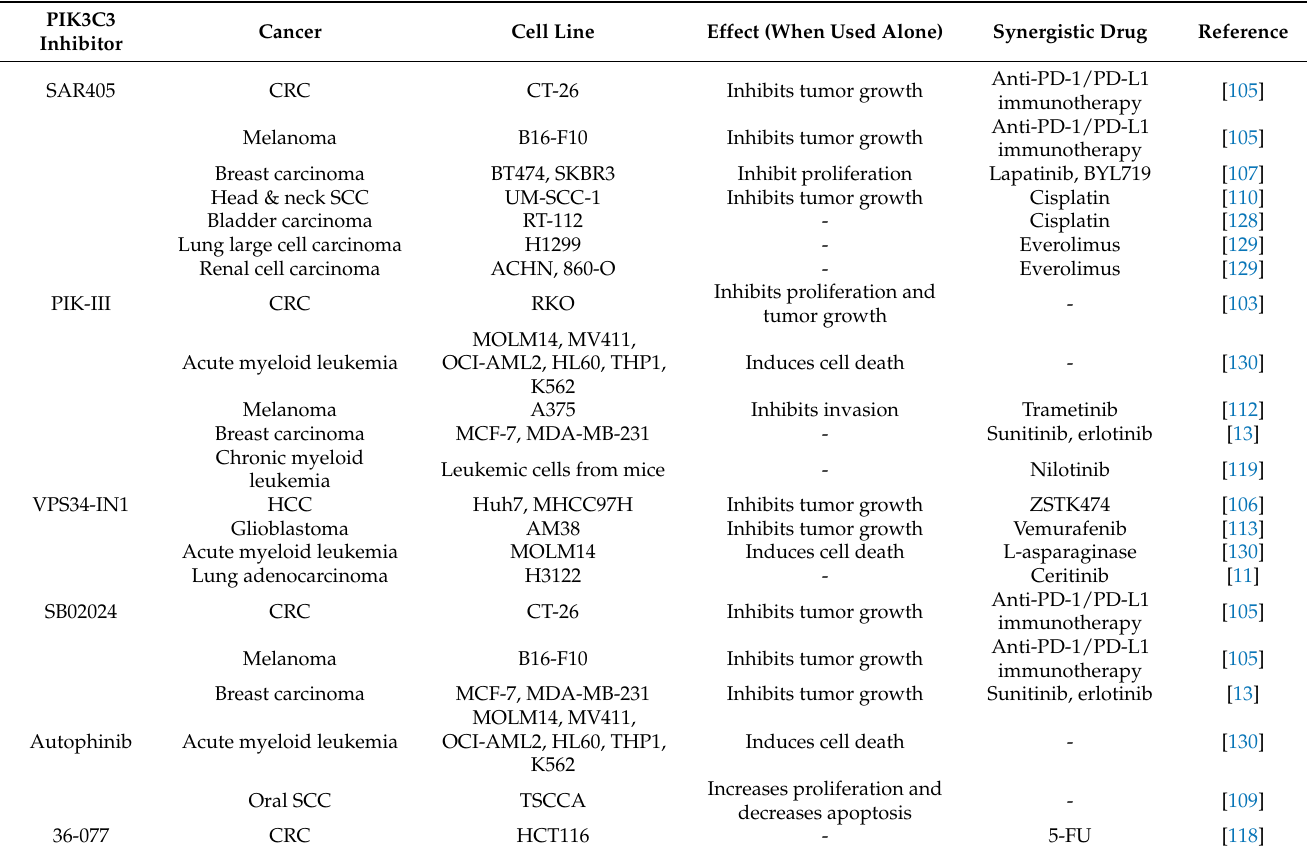
Table 3. Summary of the selective PIK3C3 inhibitors and their effects on